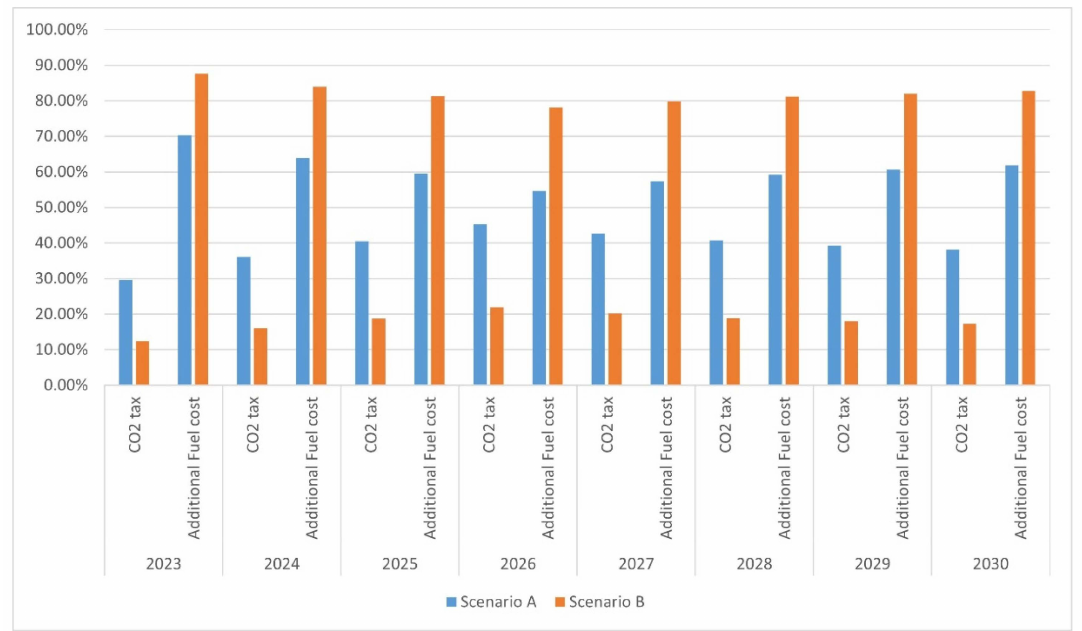
Figure 9. Breakdown of taxplus projections from 2023 to 2030 based on scenarios A and B for extra-EU imports/exports. Note that fuel tax is not applicable to extra-EU imports/exports, as the vessel will optimize its route for minimum cost; thus, taxation on fuel will be